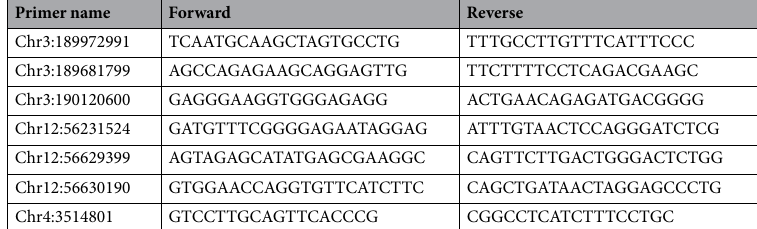
Table 1. PCR Primers for Sequences Harboring the Mutations in Present Study.